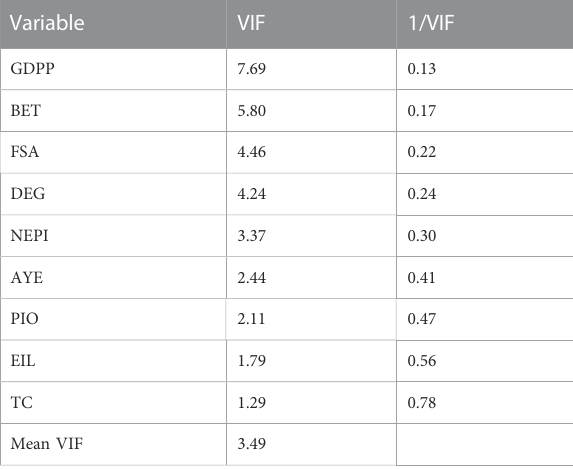
TABLE 6 VIF test of explanatory